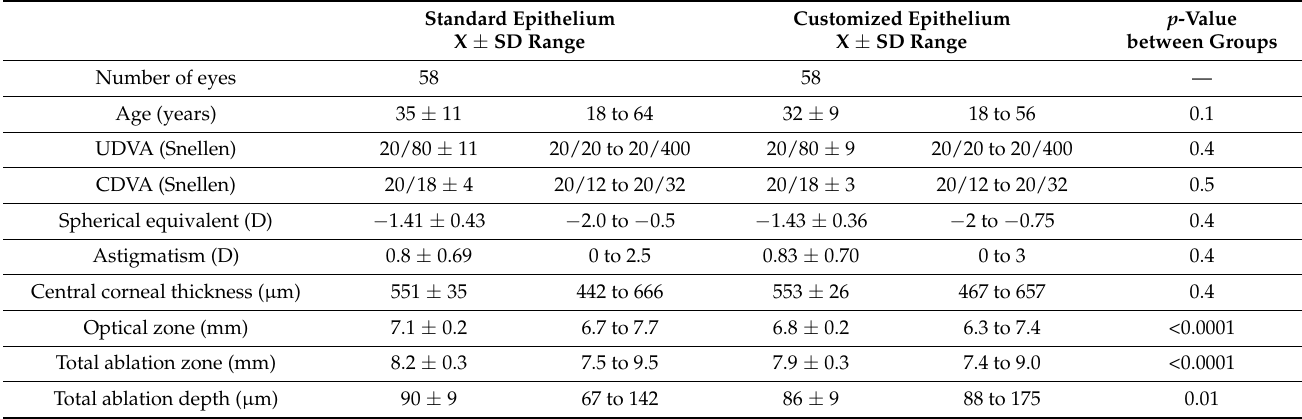
Table 2. Summarizes the values used for both groups, including age, astigmatism magnitude, and CDVA.